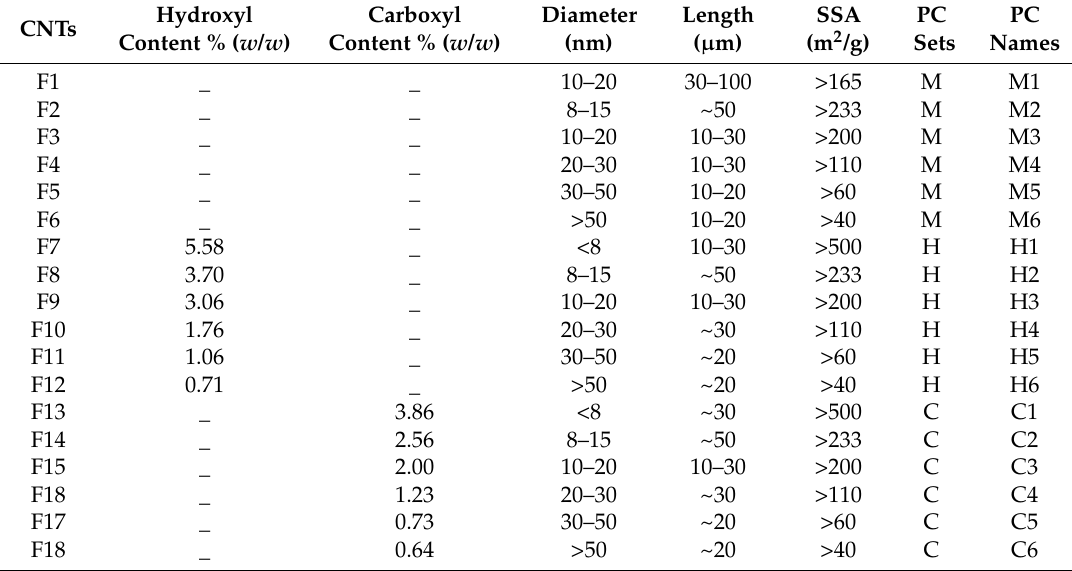
Table 1. The carbon nanotube (CNT) fillers and the polydimethylsiloxane (PDMS) composites (PCs) in the current